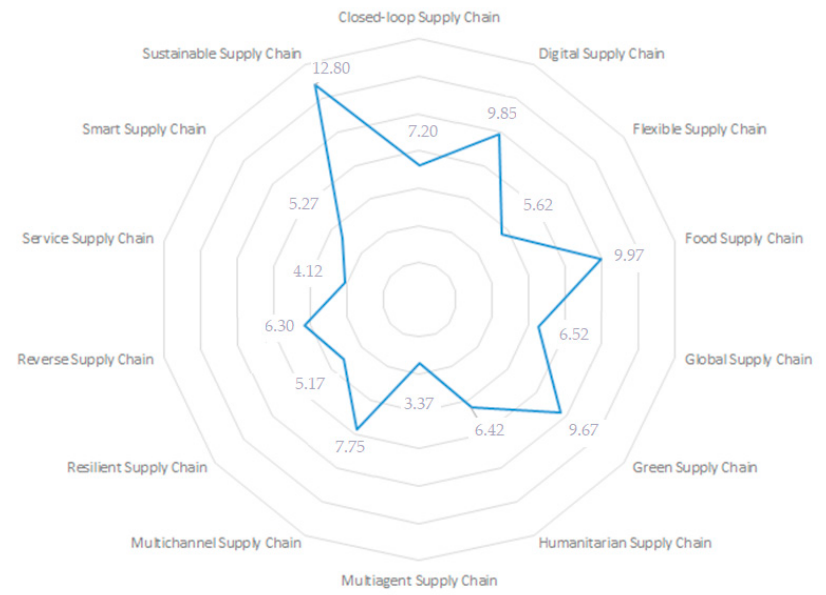
Figure 14. Mean ranking values of global theoretical trends and supply chain development directions in the context of great changes in consumer behavior according to the experts’ assessments 1–30; own elaboration based on the conducted research.